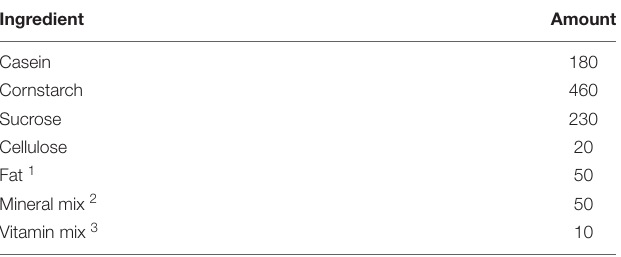
TABLE 2 | Composition of the diets (g/kg diet). TABLE 3 | Quantification of ultrastructural parameters in P10